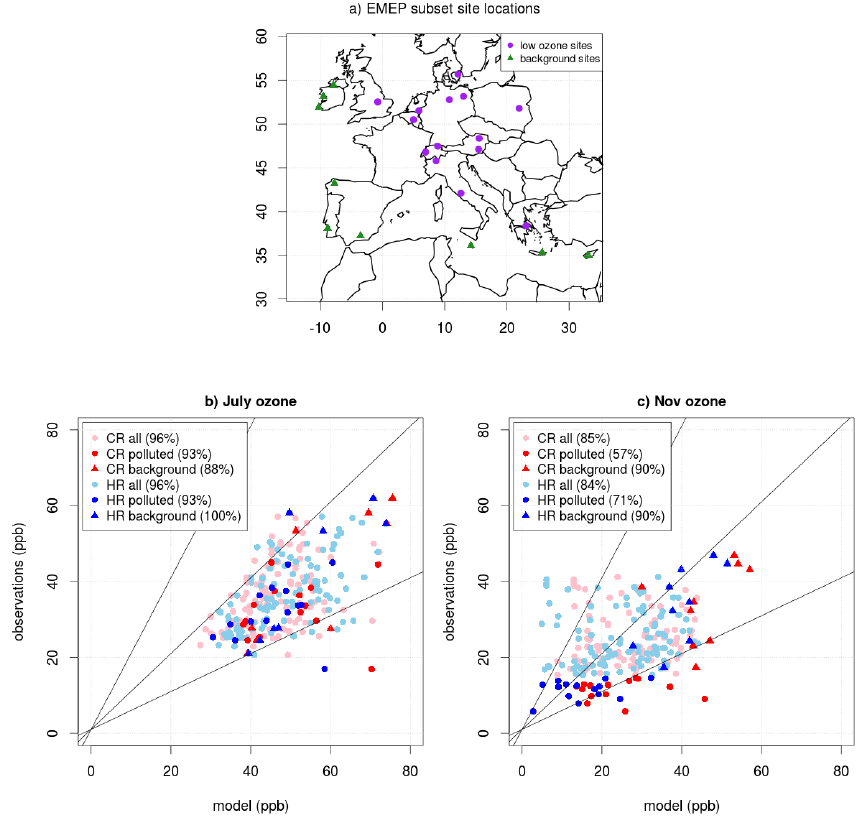
Fig. 2. (a) The locations of two subsets of the EMEP stations, showing background sites (green), and sites with low ozone (purple). A full definition of both subset criteria can be found in the text. ( b and c ) Monthly average comparison of modelled to observed ozone concentrations for sites across the EMEP network. Results are shown for climate resolution (red) and high resolution (blue). Polluted sites are highlighted in bold circles, and background sites in bold triangles. The percentage of model concentrations within a factor of 2 of the observations is included in the legend.